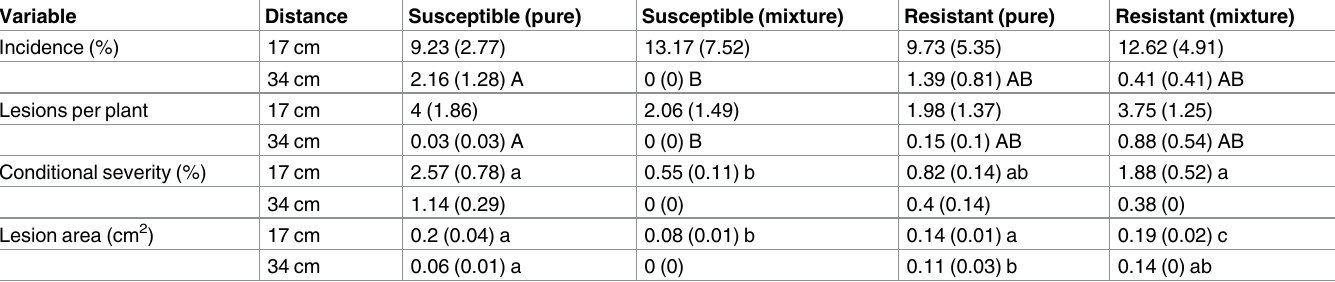
Spore flux depended greatly on vertical (Fig 4) and horizontal (Table 2) distance to the inoculum source. Spore flux decrease with height in the canopy was highly significant ( P = 6.8 × 10 −14 ). Highest spore fluxes were observed up to 10 cm above inoculum source height (20 cm), while hardly any spores were trapped higher than 30 cm above the inoculum source. Most susceptible top leaves therefore received far fewer spores than bottom leaves. In this experiment, we used an artificial source of inoculum. Incoming spore fluxes were there- fore similar for both cultivars, for a given rain type. However, spore fluxes measured within the first row differed between cultivars. Spore fluxes trapped within canopies were reduced by up to 10 compared to similar incoming fluxes measured without canopy. In the absence of Table 2. Diseaseindicators at different distances from the inoculum source in pure stand and mixture.